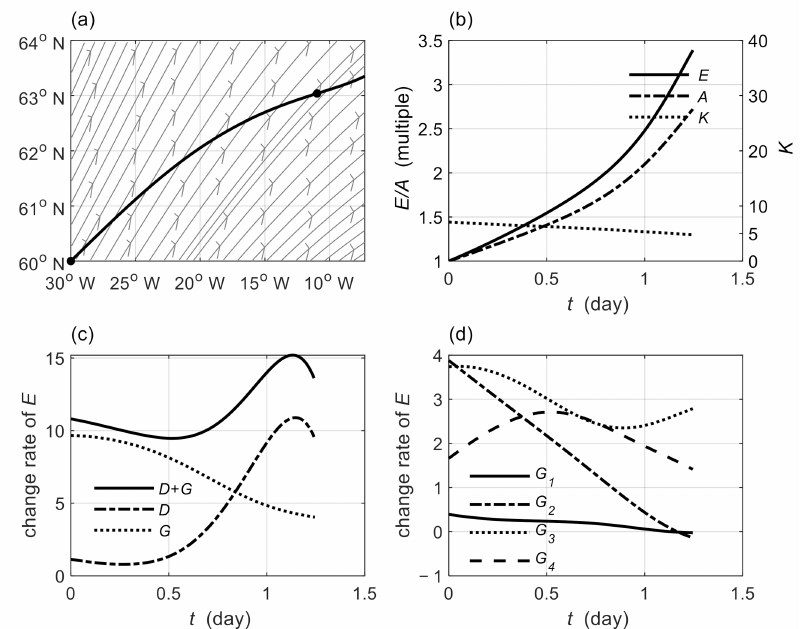
Figure 5. Ray path (solid black dots denoting the one day interval) of the wave (the source is set to 30 ◦ W, 60 ◦ N) with a period T = 30 days ( a ). The variations in wave energy ( E , solid line), amplitude ( A , dash-dotted line) and the total wavenumber ( K , dotted line) along the ray ( b ). The variations in the divergence of the group velocity (dash-dotted line, shortened as D ), the energy budget from the basic flow (dotted line, shortened as G ) and the sum of them (change rate of wave energy) along the ray ( c ). The variations in the four components of the energy budget from the basic flow (shortened as G 1 , G 2 , G 3 and G 4 , respectively, and their sum equals G ) along the ray ( d ). D and G ( G 1 , G 2 , G 3 and G 4 ) have been magnified 10 6 times to glory the